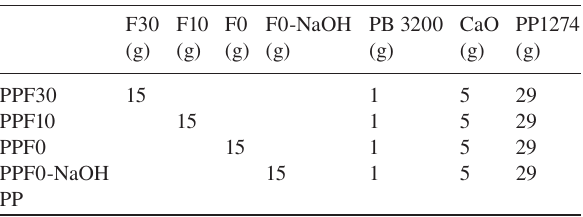
Table 1 Formulation of fl ax/PP